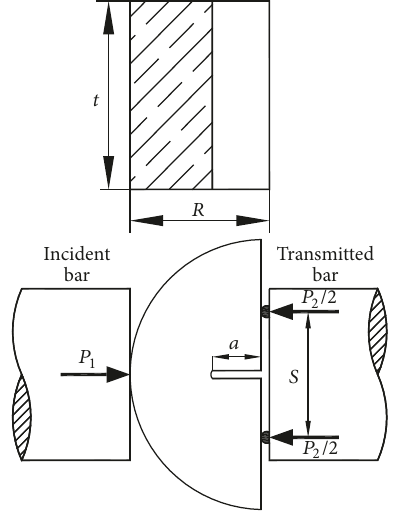
Figure 3: Dimension of NSCB specimen.